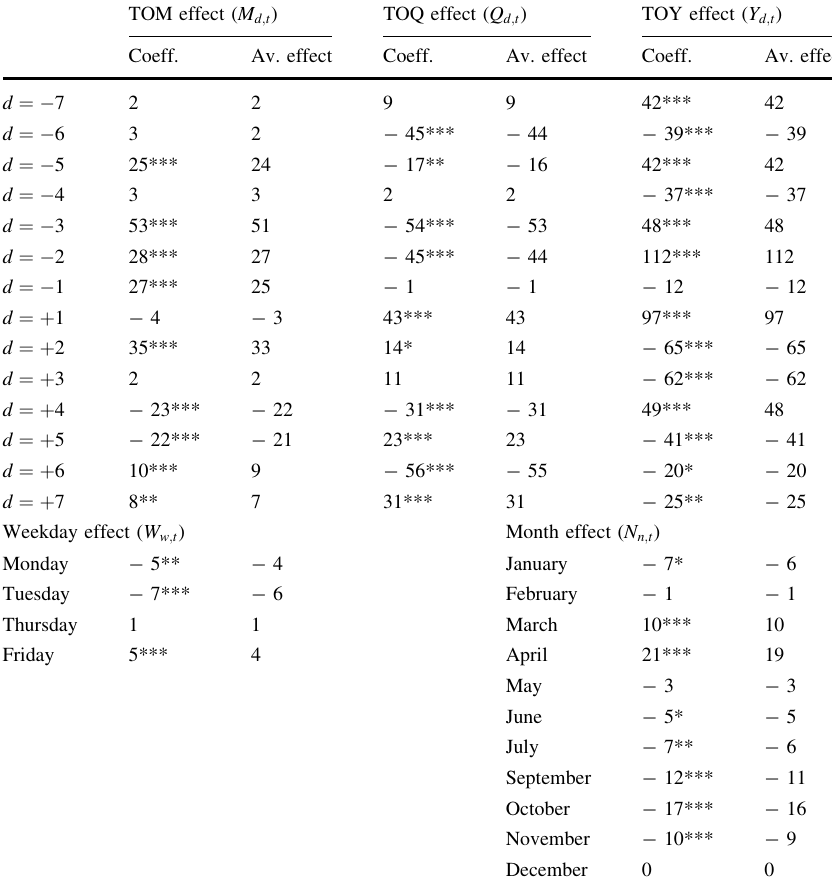
Table 11 Seasonality in returns after removing news